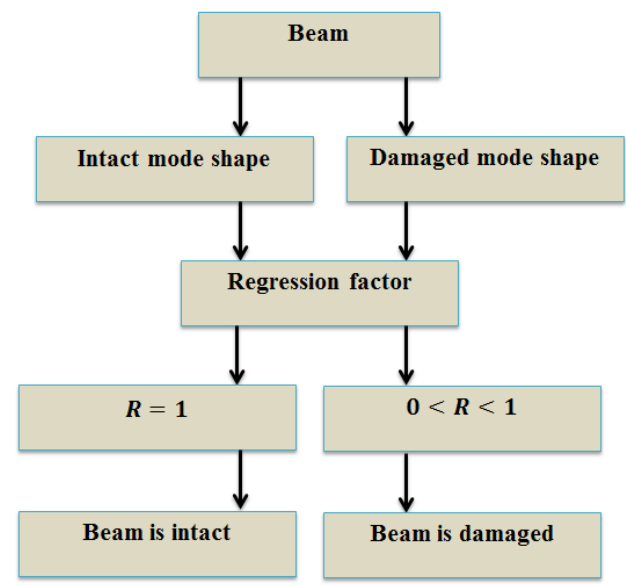
Figure 1. Flowchart of beam structure’s health monitoring by regression indicator.